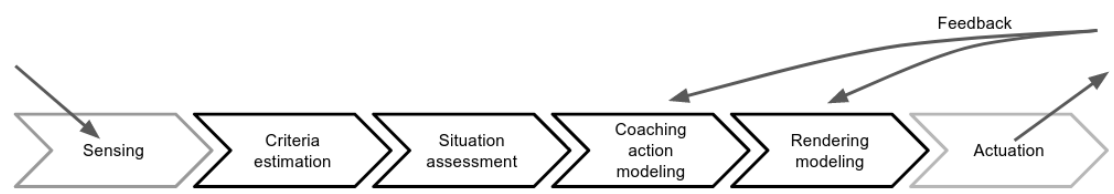
Figure 2. A generalized diagram of coaching pipelines, the basis of the SAAM coaching system.